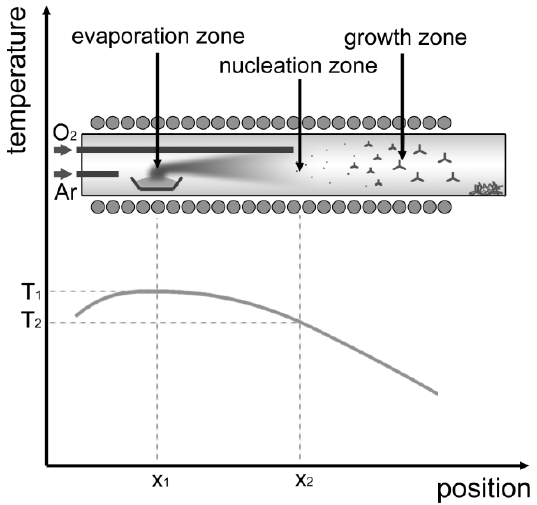
Figure 1. Vapour Phase Deposition